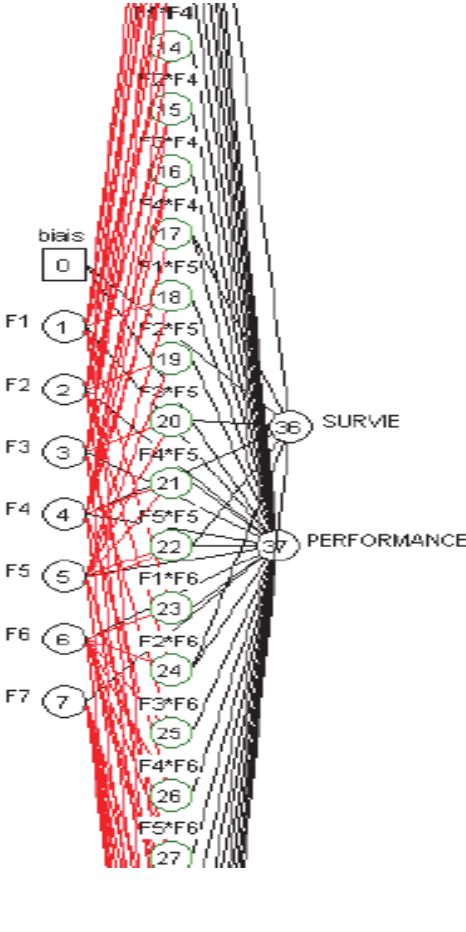
Fig. 5. Neural network